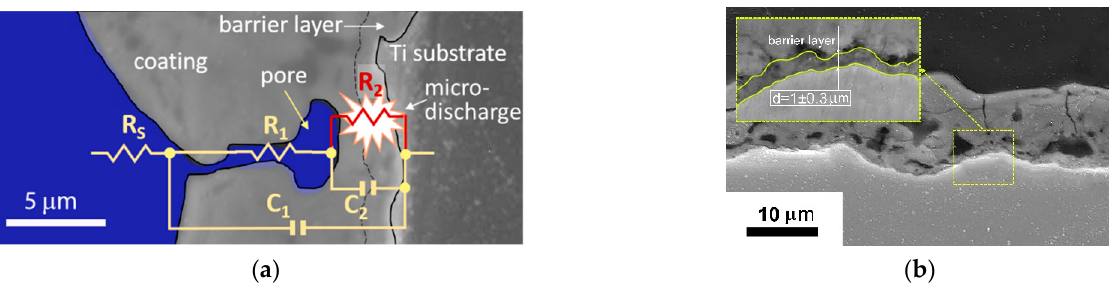
Figure 10. Typical PEO coating cross-section after 180 s of the treatment: ( a ) in situ equivalent circuit corresponding to the PEO process mechanism; ( b ) barrier layer of the PEO coating.